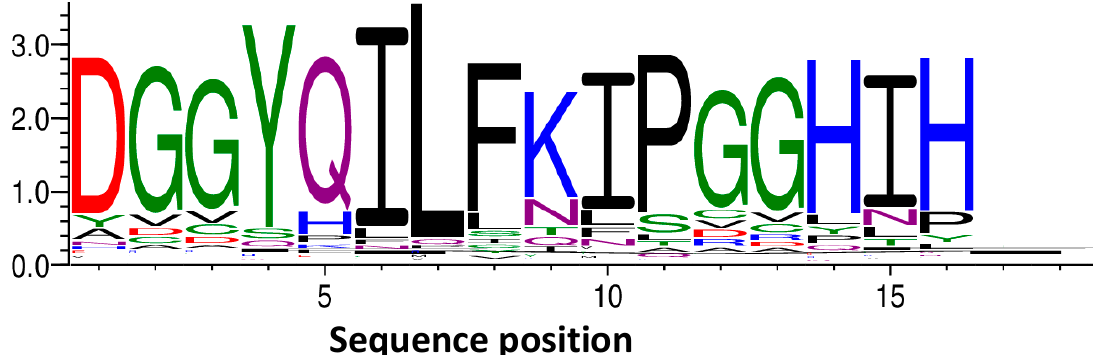
Figure 4. Position-specific scoring matrix of the TF2D-5 cluster. After analysis of the NGS data as well as the preliminary screening experiments, the D-peptide TF2D-5 and its derivate TF2D-5a were selected as lead candidates for the development of a therapeutic agent against tauopathies. Out of more than 600,000 sequences that were able to pass the filter, TF2D-5 amounted to about 3% of all sequences. The shown PSSM was generated with the Hammock program and was derived from 1970 different sequences that were obtained during selection. Letter size corresponds to the frequency with which an amino acid was present at the depicted position in the PSSM. These sequences were all enriched with different intensities, and the biggest letters for each position formed the exact sequence of TF2D-5 after clustering. This led to the decision to use the D-peptide with the sequence dGGyqilfkipGGhih for future experiments. TF2D-5a is TF2D-5 with five additional D-arginine residues at the C-term: dGGyqilfkipGGhihrrrrr.